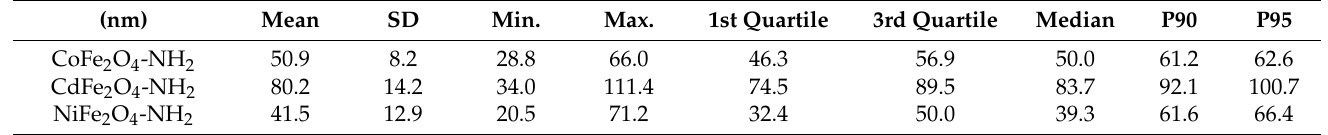
Table 1. Results of the size analysis (in nm) of the ferrite nanospheres (based on HRTEM pictures). (nm) Mean SD (nm) Mean